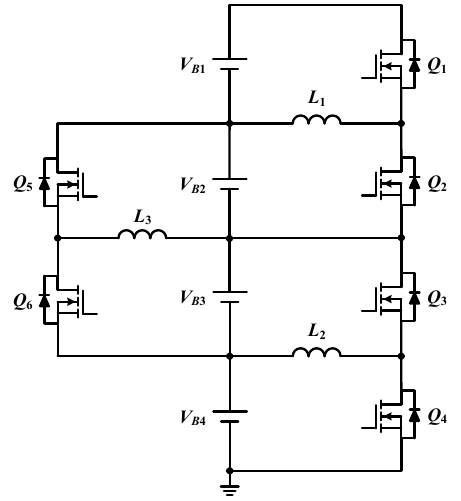
Figure 2. Equalizer circuit with four batteries.